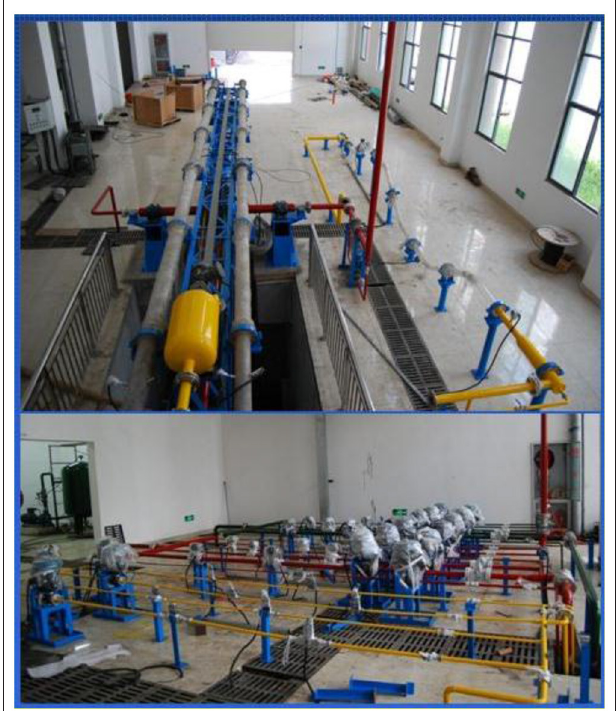
FIGURE 1 | Photos of experimental setup at Yangtze